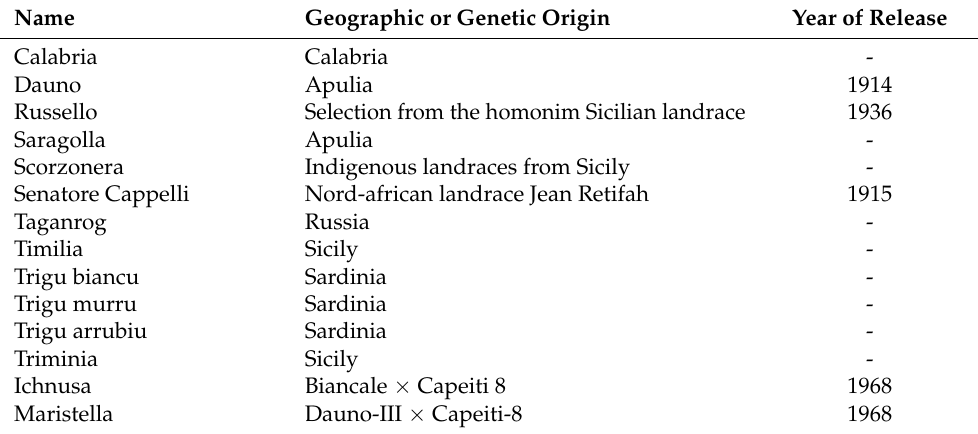
Table 1. The investigated genotypes with the relative year of release and geographic or genetic